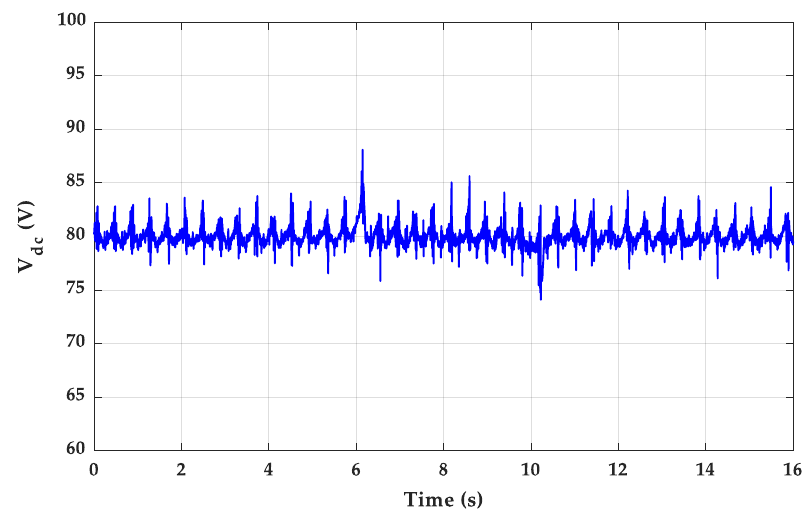
Figure 10. The VSI output d -axis current component (Experiment 1).